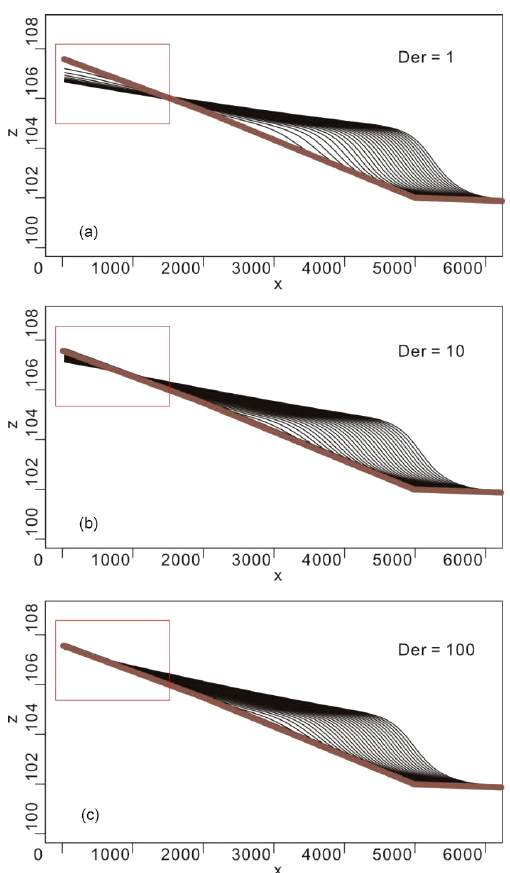
Figure 2. Dip direction section with different Der values ( a : Der = 1; b : Der = 10; c : Der = 100). Erosion will be switched off if Der is large